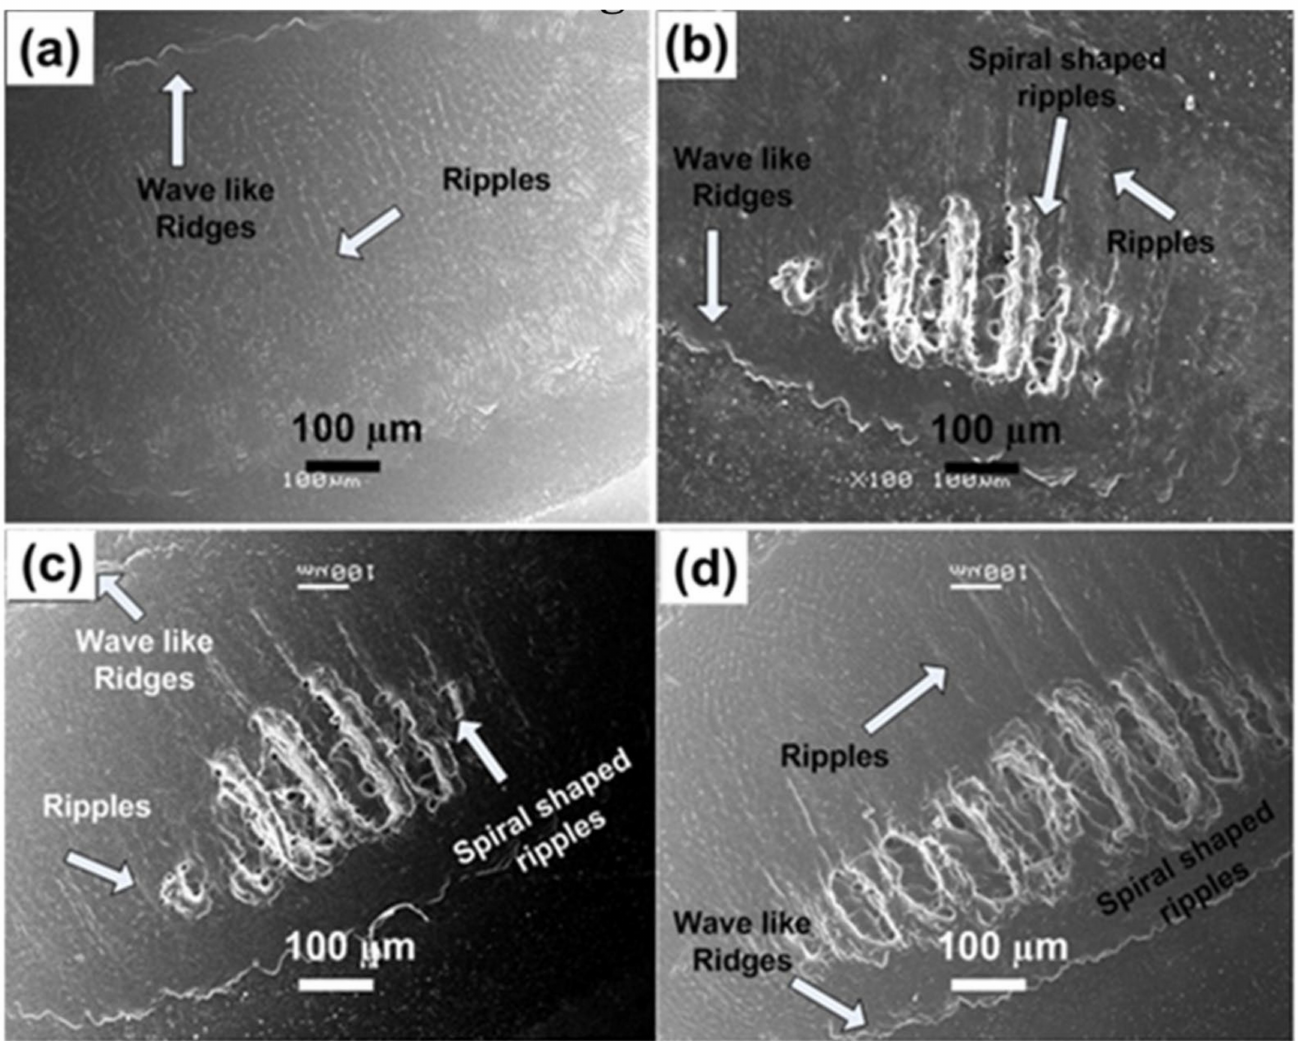
Figure 3. SEM images revealing the surface morphology of Al exposed to 100 pulses of ns laser at wavelength of 248 nm, pulse duration of 18 ns and repetition rate of 20 Hz at various fluences of ( a ) 0.86 J · cm − 2 , ( b ) 1 J · cm − 2 , ( c ) 1.13 J · cm − 2 and ( d ) 1.27 J · cm − 2 , under an ambient environment of O 2 at a pressure of 100 torr. Enlarged views (at higher magnification) of central ablated region after irradiation in ambient environment of O 2 for 100 laser pulses and for different laser fluences at pressure of 100 torr are shown in Figure 4a–d. Wave-like structures or small-scale ripples along with wrinkles and canals are observed in Figure 4a. Fibrous structures or small scale ripples are also presented in Figure